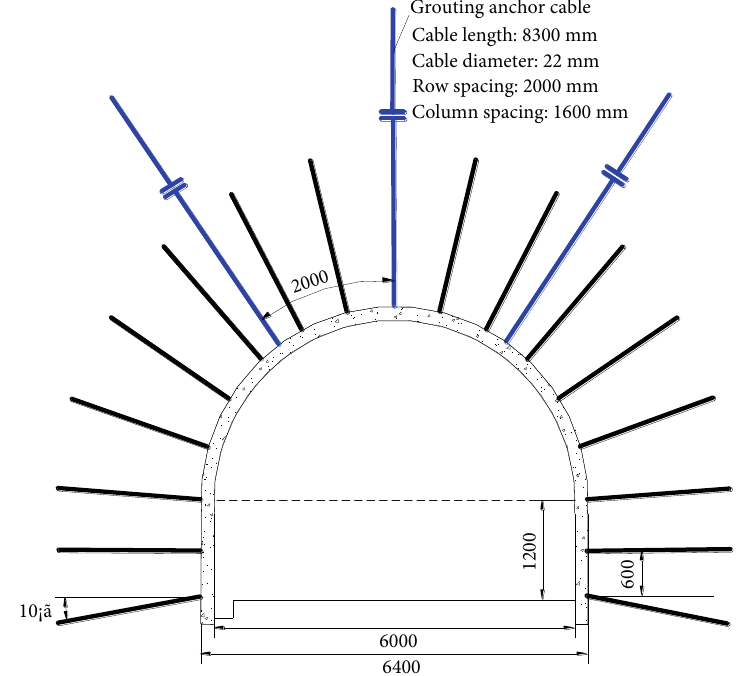
Figure 6: Layout of grouting cable anchor.